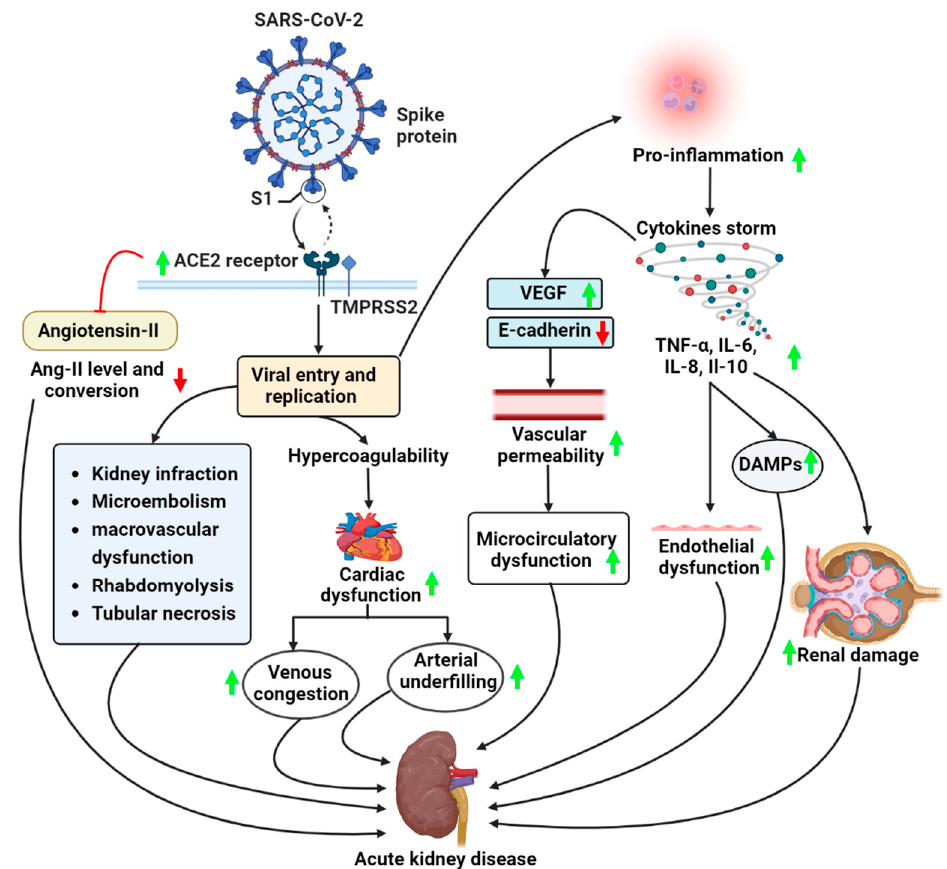
Figure 1. This illustration shows the pathogenesis of COVID-19-associated acute kidney disease (AKD). The receptor binding domain (RBD) of the virus binds to the ACE2 receptor. TMPRSS2 proteases cleave the spike protein of the virus. This supports viral entry from the plasma membrane and replication of the virus, resulting in increased pro-inflammation and cytokine storms, leading to microcirculatory dysfunction, endothelial dysfunction, and renal damage. However, viral entry and replication also lead to increased hypercoagulation, which ultimately leads to increasing cardiac dysfunction. This results in increasing venous congestion and arterial underfilling, which leads to AKD. (Red arrow-Downregulation; Green arrow-Upregulation). (Abbreviations: VEGF, vascular endothelial growth factor; TNF- α , tumor necrosis factor-alpha; IL-6, interleukin-6; IL-8, interleukin-8; IL-10, interleukin-10; DAMPs, damage-associated molecular patterns).